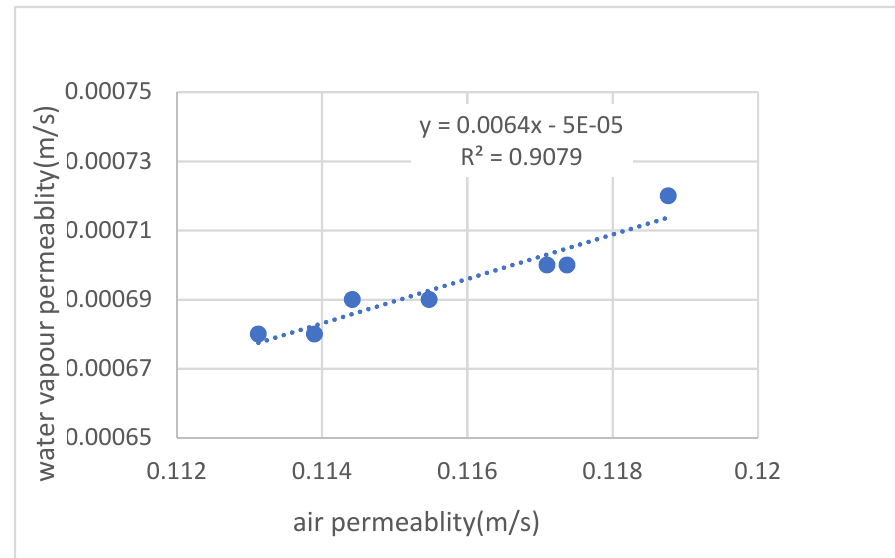
Figure 1. Air permeability and water vapour permeability relation.